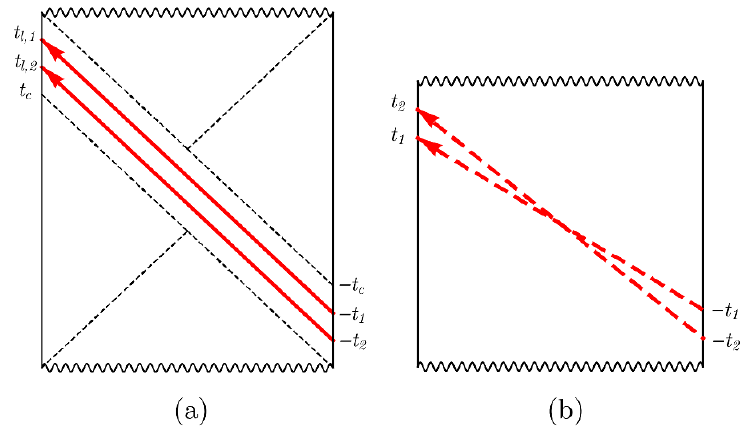
Figure 10 . The relation between emission time and arrival time in two di(cid:11)erent regimes. (a) is the semi-classical regime, in which the earlier a signal (smaller (cid:0) t s ) is sent, the earlier (smaller t l ) the arrival of the signal at the other boundary. In particular, as (cid:0) t s ! (cid:0)1 , t l ( t s ) ! t c which is the earliest possible arrival time, and as (cid:0) t s ! (cid:0) t c , t l ( t s ) ! + 1 . (b) describes the situation of (5.6) and the CFT results of section 4, where the arrival time t is the negative of emission time (cid:0) t s